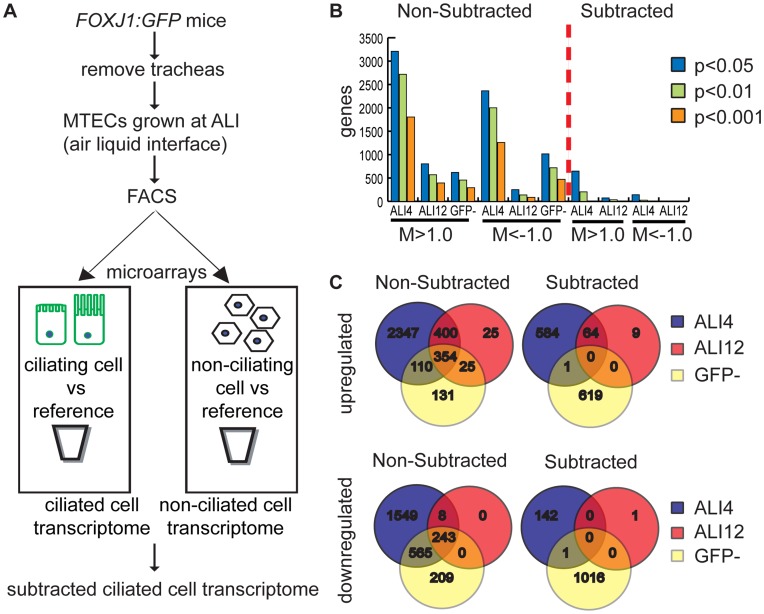
Subtractive analysis of MTEC microarray data.(A) Experimental flowchart detailing microarray analysis. (B) The number of differentially expressed genes in ciliated MTECs at adj. p-values <0.05, <0.01 and <0.001 before subtraction (non-subtracted) and after subtraction. The non-subtracted gene list is the transcriptional profile of GFP+ cells compared to a universal mouse reference RNA. The subtracted gene list was derived analytically by comparing the transcriptional profile of GFP+ cells to that of GFP- cells from MTEC cultures. The number of genes that show 2-fold or greater differential expression and have adjusted p-values of 0.05, 0.01 and 0.001 are shown before and after subtractive analysis. After subtraction, 649 genes were significantly upregulated at ALI+4 with respect to GFP- cells, and 73 genes at ALI+12. 143 genes were downregulated at ALI+4 and none at ALI+12 (adj. p<0.05). (C) The overlap of significantly upregulated and downregulated genes (adj. p<0.05) from ALI+4, ALI+12 and GFP- pools decreases after subtraction. The GFP- group in both panels represents genes that are differentially expressed in non-ciliated cells relative to the universal reference RNA. M = log2(fold change).